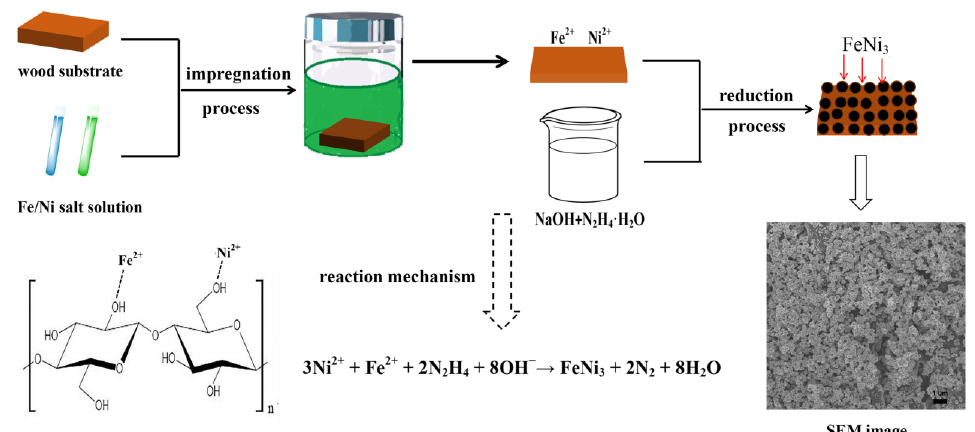
Figure 1. Schematic of preparation for FeNi 3 modified wood